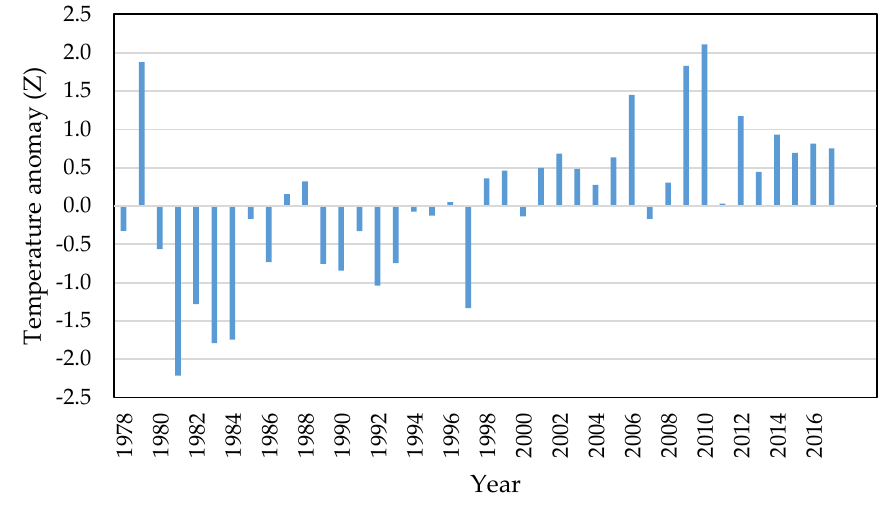
Figure 2. Standardized anomaly ( Z ) in annual average temperature at Khulna (1978–2017).